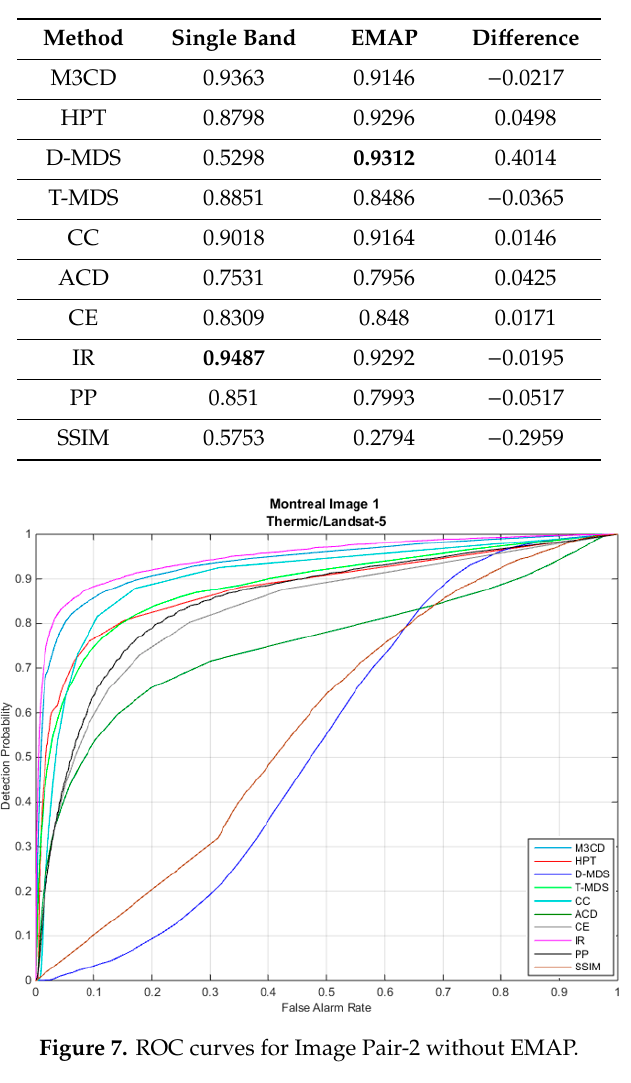
Table 3. AUC values and di ff erences between single band and EMAP cases for dataset-2. Bold numbers indicate the best performing method in each column.